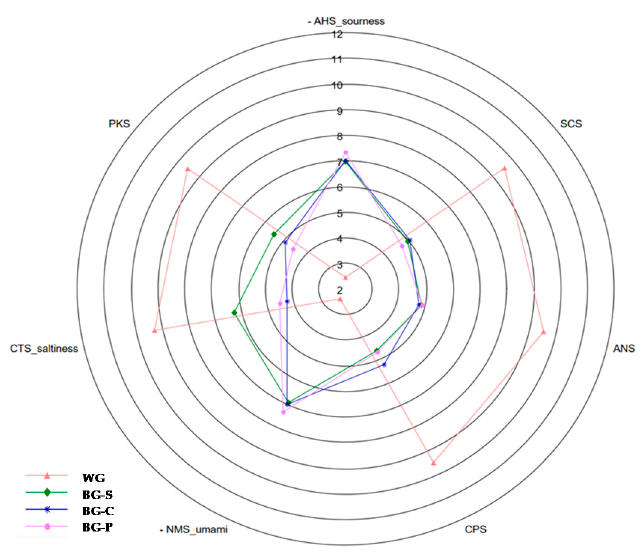
Figure 5. Radar map of e-tongue data for fresh and black garlic. WG—white garlic, BG-C—black garlic cloves, BG-P—black garlic powder, BG-S—black garlic spreading paste. Sourness (AHS) increased after the fermentation process (1.90–7.30), and the values between black garlic samples were similar between groups. In the case of umami (NMS), taste was enhanced after thermal process and increased from 1.90 (WG) to 7.00–7.40 in BG and BG-P, respectively. According to the results obtained by Park and Kim (2022) [67], lyophilized chives (Allium), which contain free amino acids, may enhance the umami taste in the product. The saltiness (CTS) decreased after the fermentation process, from 9.30 to 6.80 (BG-S), 5.50 (BG-P) and 5.20 (BG-C). The fresh garlic showed a strong bitter